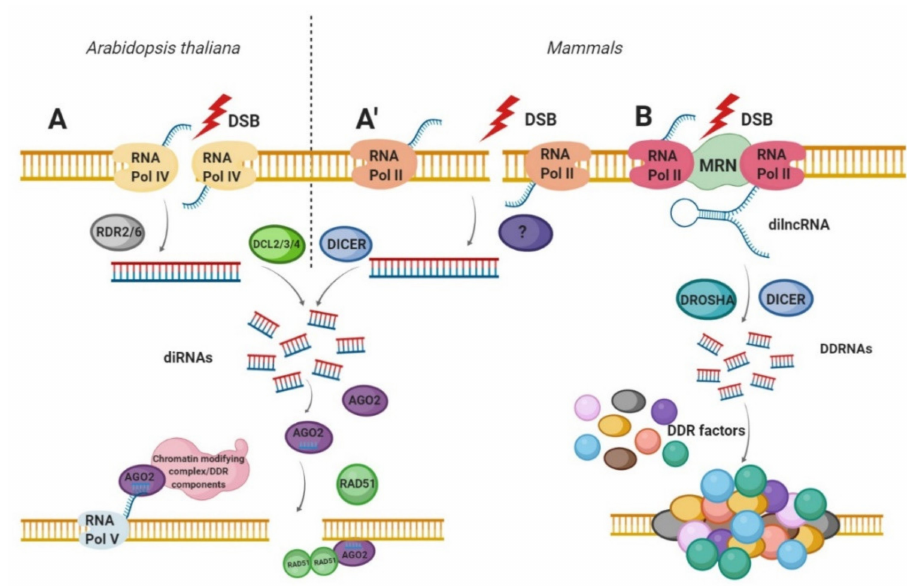
Figure 2. Biogenesis of double-strand break-induced RNA (diRNA) and DNA damage response small RNA (DDRNA). ( A ) diRNAs biogenesis in Arabidopsis thaliana and ( A’ ) in human cells. After DSB induction, RNA Pol IV (in plants) and RNA Pol II (in humans) transcribe the DNA in the vicinity of DSB to produce the primary transcripts. RDR2 or RDR6 in plants then uses these ssRNA as a template for dsRNA synthesis. In humans, the molecular factors involved in this step have not yet been characterized. Subsequently, dsRNAs are cleaved by DCL2, DCL3 or DCL4 (in plants) or by DICER (in mammals), to produce a pool of 21–24 nt long small RNAs (diRNAs). Next, diRNAs are incorporated into AGO2 proteins leading to the removal of the passenger strand. The AGO2—diRNA complexes act as a guide for DNA damage response (DDR) factors such as RAD51 or chromatin remodelers to the DSB. ( B ) The DDRNAs biogenesis in mammals. After DSB induction, primary sensor of DSBs—MRN complex is bound to the site of damaged DNA. Next, the RNA Pol II synthesizes damage-induced long noncoding RNAs (dilncRNAs) from and towards DNA ends. dilncRNAs are then cleaved by DICER and DOSHA, generating DDRNA that participates in DDR signal